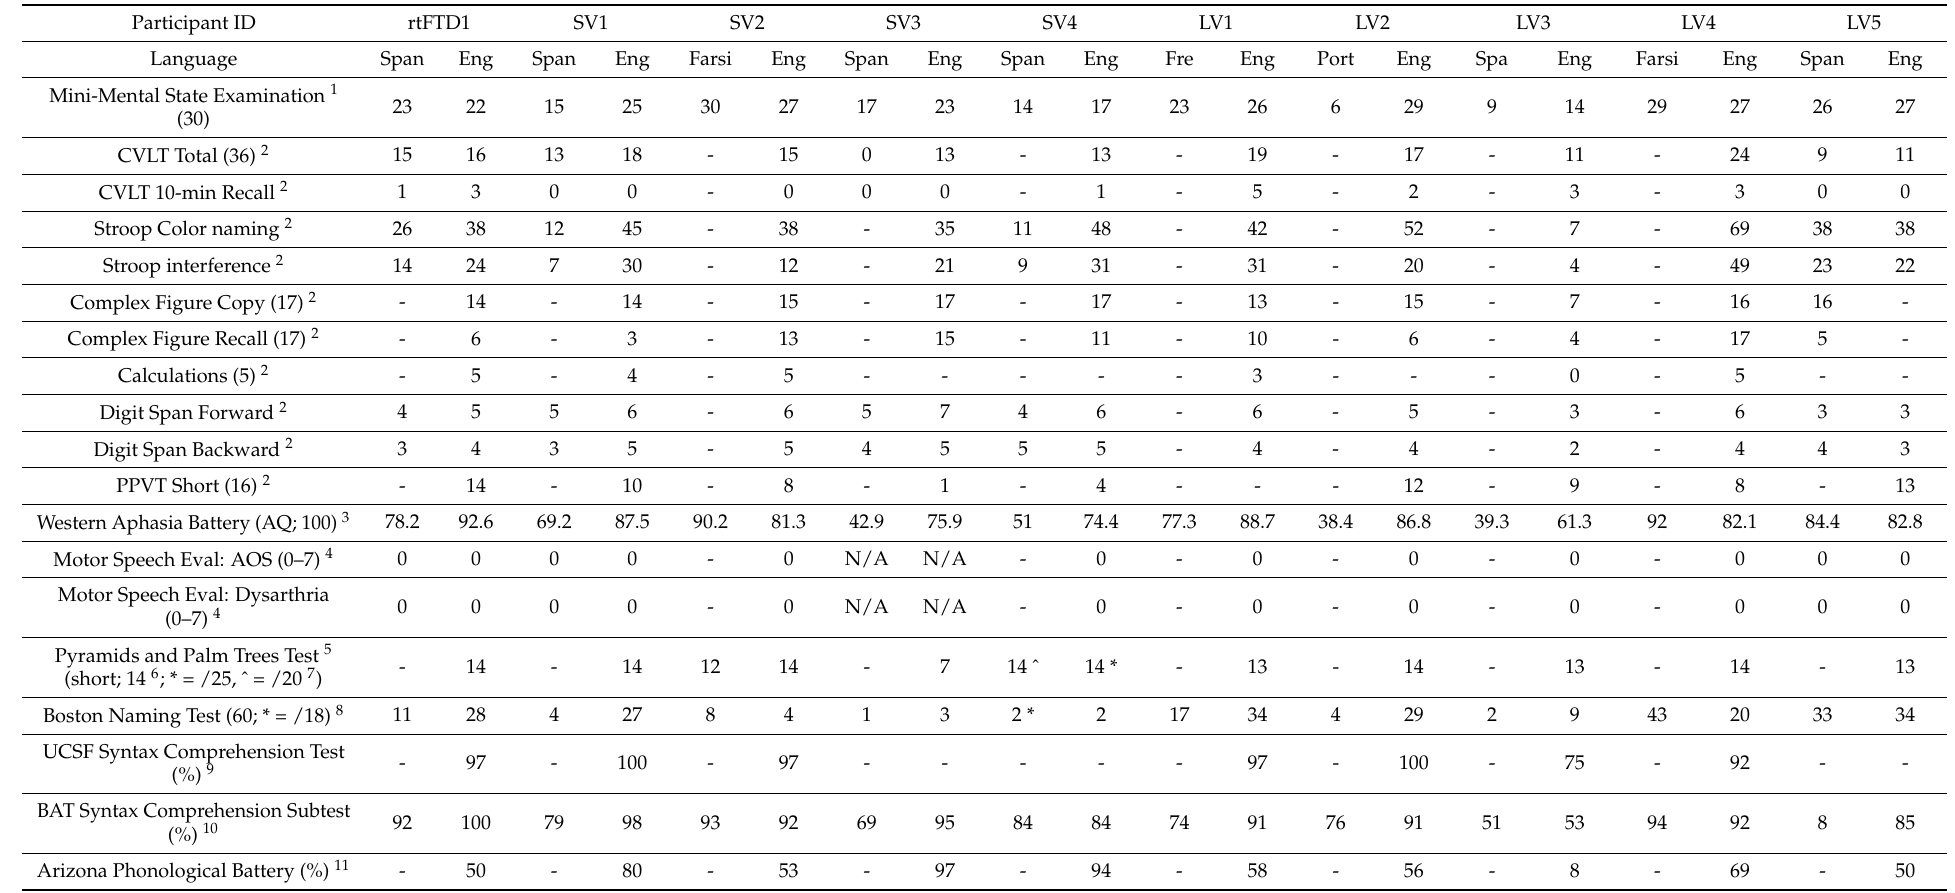
Table 2. Pre-Treatment Assessment